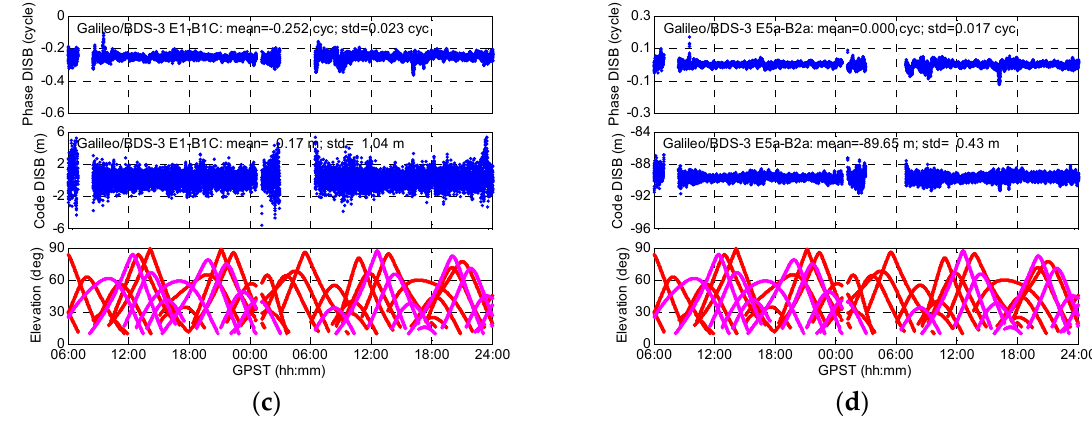
Figure 8. Estimated ISBs between GPS/BDS-3 L1-B1C ( a ), L5-B2a ( b ), and Galileo/BDS-3 E1-B1C ( c ),